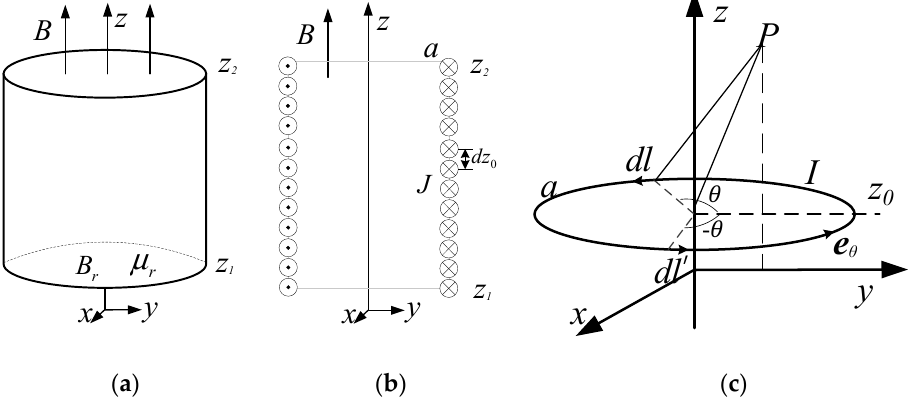
Figure 2. Calculation model of a cylindrical magnet ( a ). Approximation of a permanent magnet as the equivalent surface current density ( b ). Single-turn current for calculation ( c ).